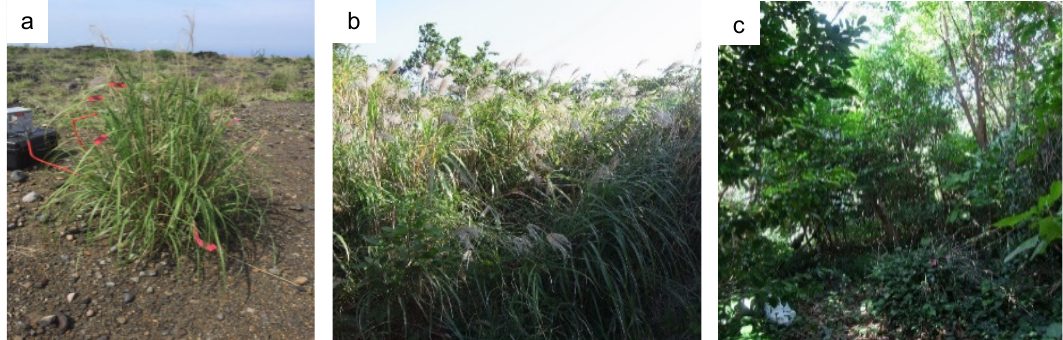
Figure A1. Daily rainfall (bars) and daily average air temperature (T air) (solid line) from June 2017 to July 2018. Pentagonal star represents the survey implementation day.